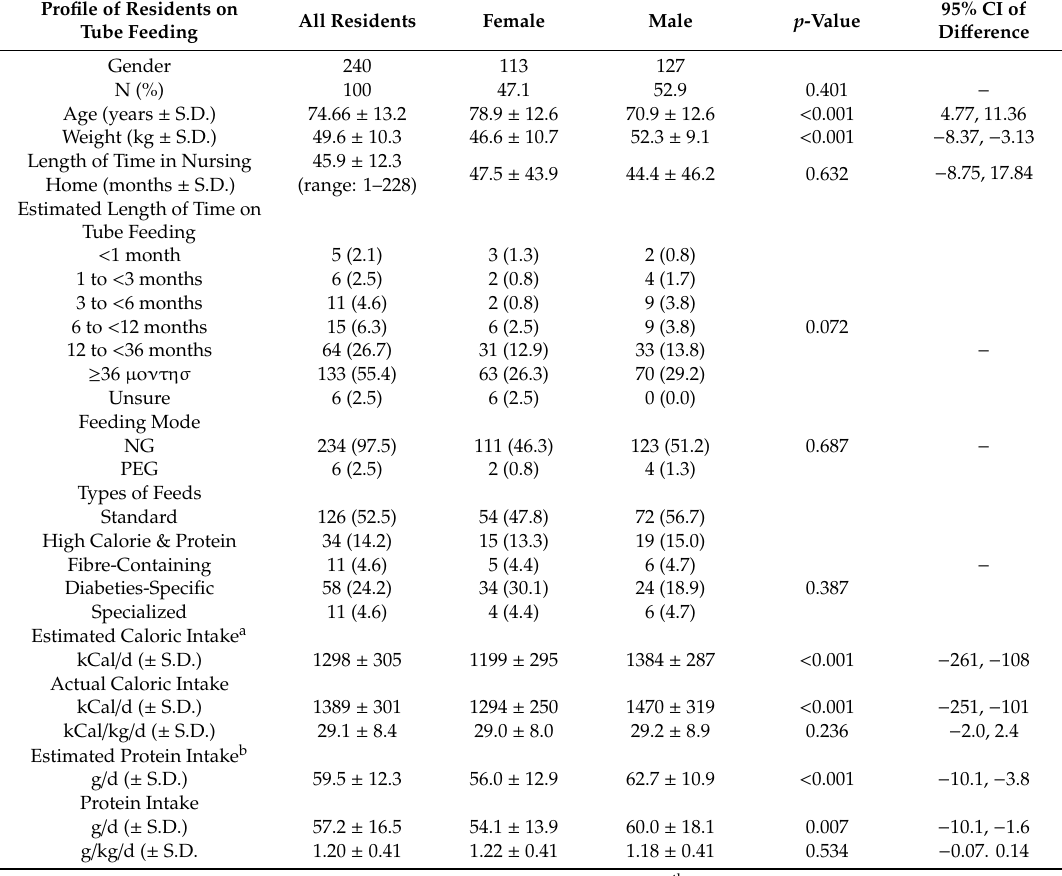
Table 3. Nutritional Profile of Residents in Nursing Homes on Tube